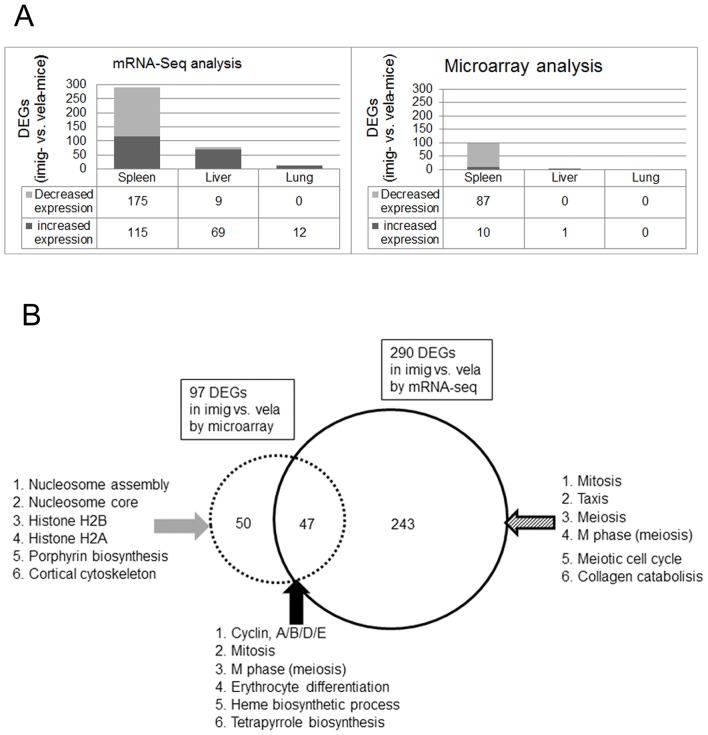
Comparative analyses of the DEGs identified by direct comparison of imig- vs. vela-treatment.For the analyses in this figure imig- and vela- treated samples were directly compared without normalization to WT gene expression in the corresponding tissue. (A) The Y-axis represents the number of DEGs in imig-treatment compared to the number with vela-treatment. The X-axis represents the different tissues. Three times more genes were detected by mRNA-Seq than that by microarray analysis. The number of genes are color coded for increased expression (dark grey) and decreased expression (light grey). Liver showed smaller DEG differences. In lung, The number of DEGs in imig- and vela-treated samples were not different. (B) Common and unique DEGs identified by microarray and mRNA-Seq in spleens. The Venn diagram of DEGs in the spleen compares the number of identified DEGs from microarray and mRNA-Seq that were different in imig- vs. vela-treatment. Compared to vela-treated spleen, 50 and 243 unique genes were identified in microarray (left) or mRNA-Seq (right) data sets in the imig-treated spleens. Forty seven genes (intersection) were common to both platforms. The GO annotation was performed using DAVID and the number of increased and decreased DEGs in the top functions identified by IPA are listed in Table S13.